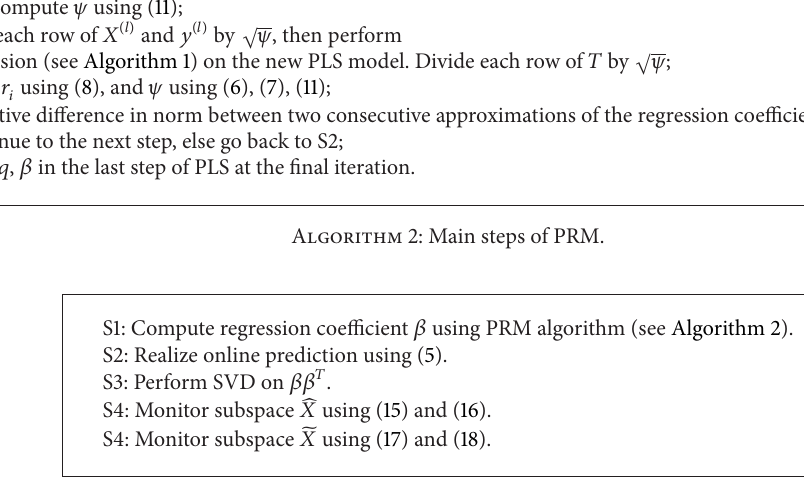
Algorithm 3: Main steps of the new prediction and diagnosis